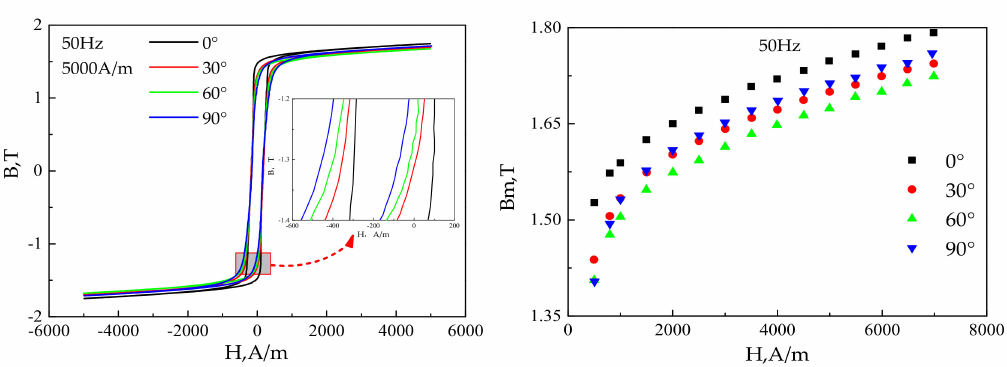
Figure 5. Hysteresis loops of Fe-0.65%Si non-oriented electrical steel at 50 Hz, 5000 A/m and Magnetization curves at 50 Hz.